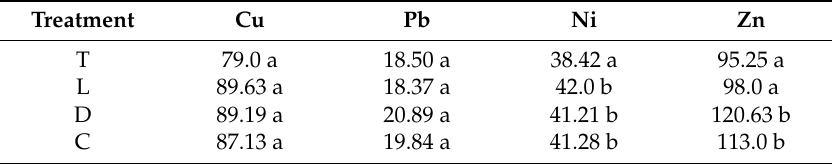
Table 3. Total concentrations of Cu, Pb, Ni, and Zi in soil (mg kg − 1 d.w.) Treatment